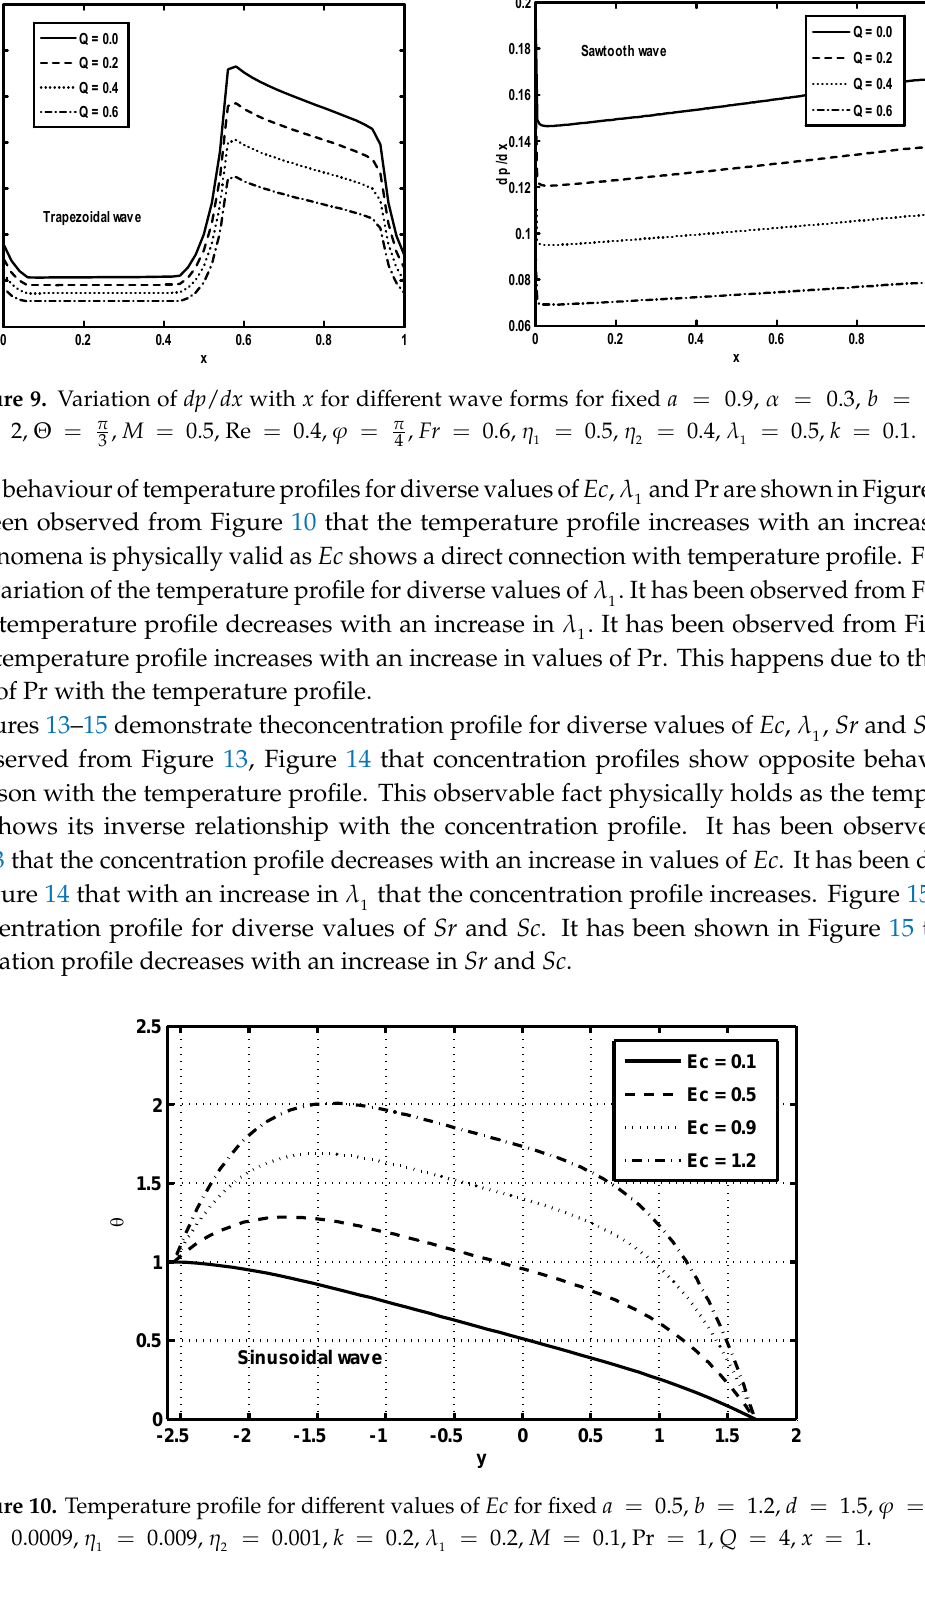
= 0.009, η = 0.001, k = 0.2, λ 1 2